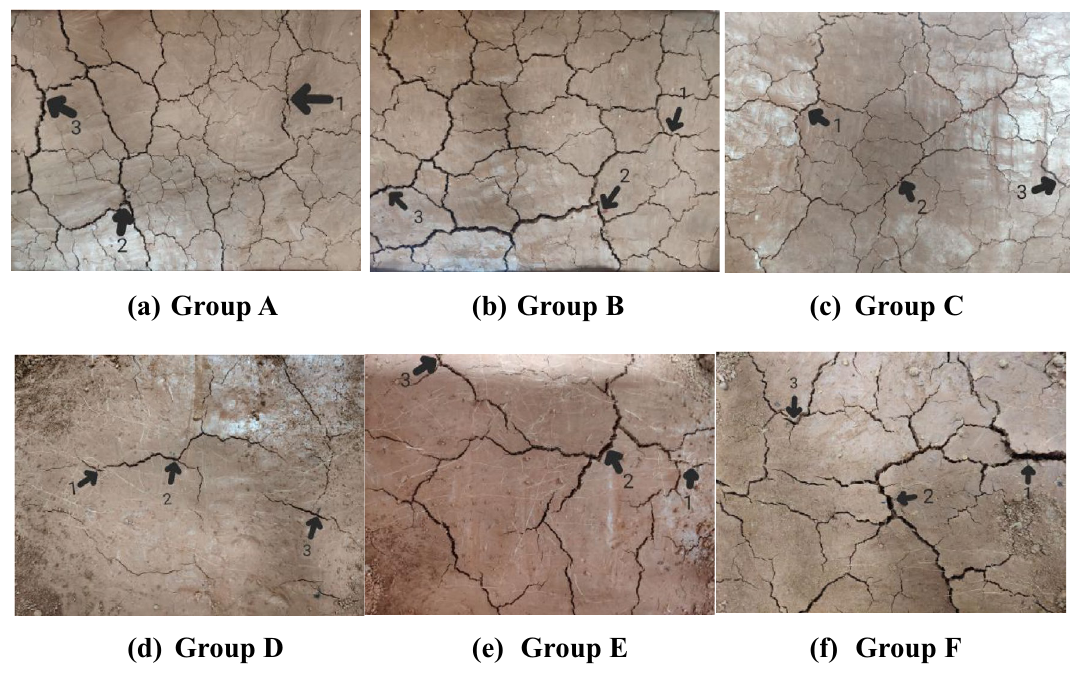
Figure 10. Measurement positions of crack width and depth of each model box ( a – f